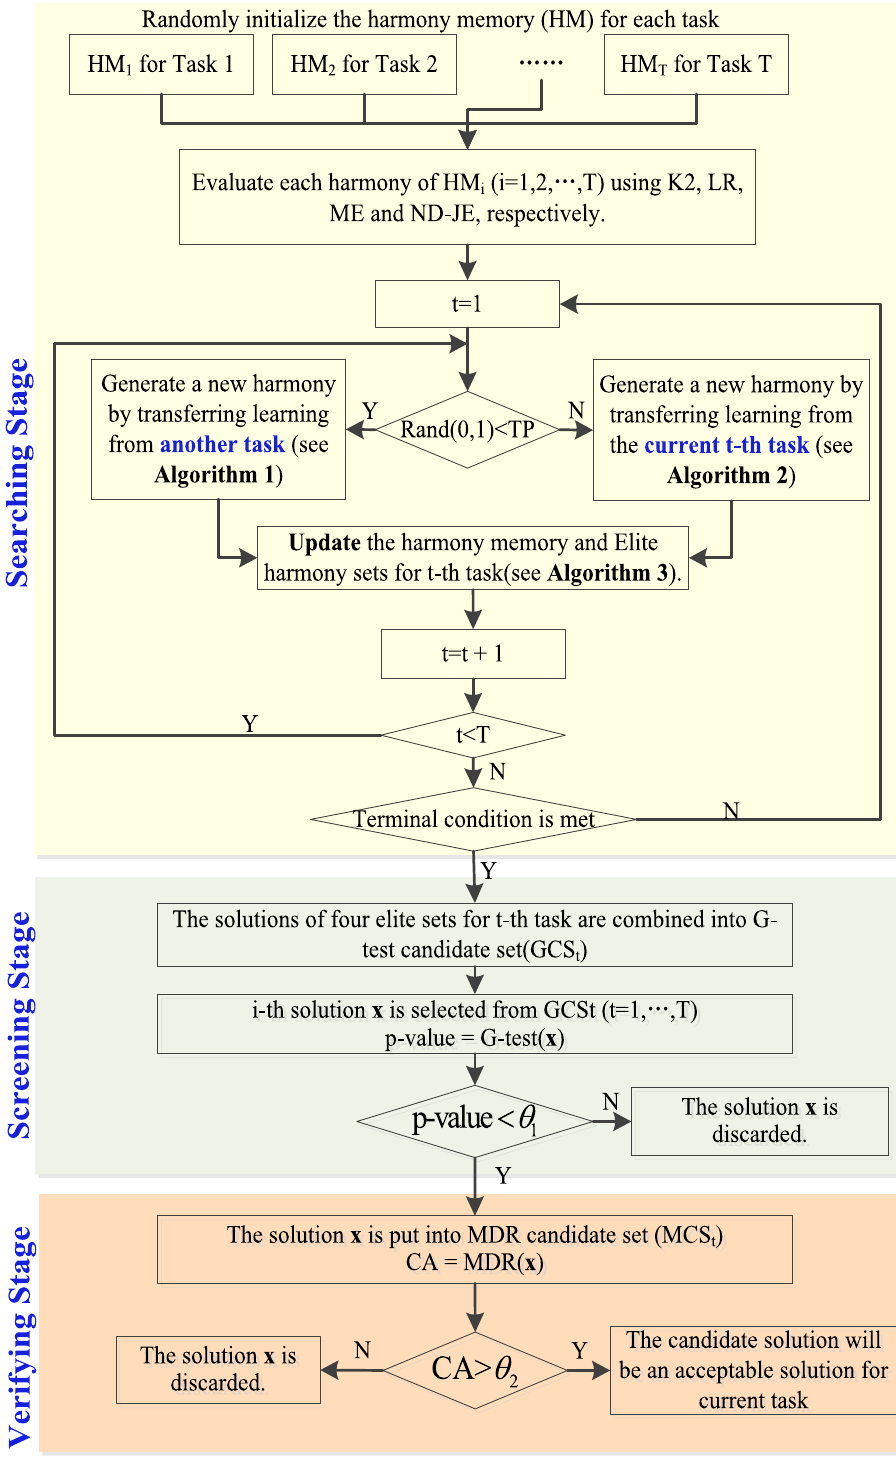
Fig. 1 The general flowchart of the proposed algorithm MTHSA-DHEI. In the search stage, the multitasking harmony search aims to discover some potential SNP combinations that have a strong association with disease status. In the screening stage, the G-test is employed to eliminate some SNP combinations without a significance level. MDR is used to verify the classification ability of candidate solutions in the 3rd